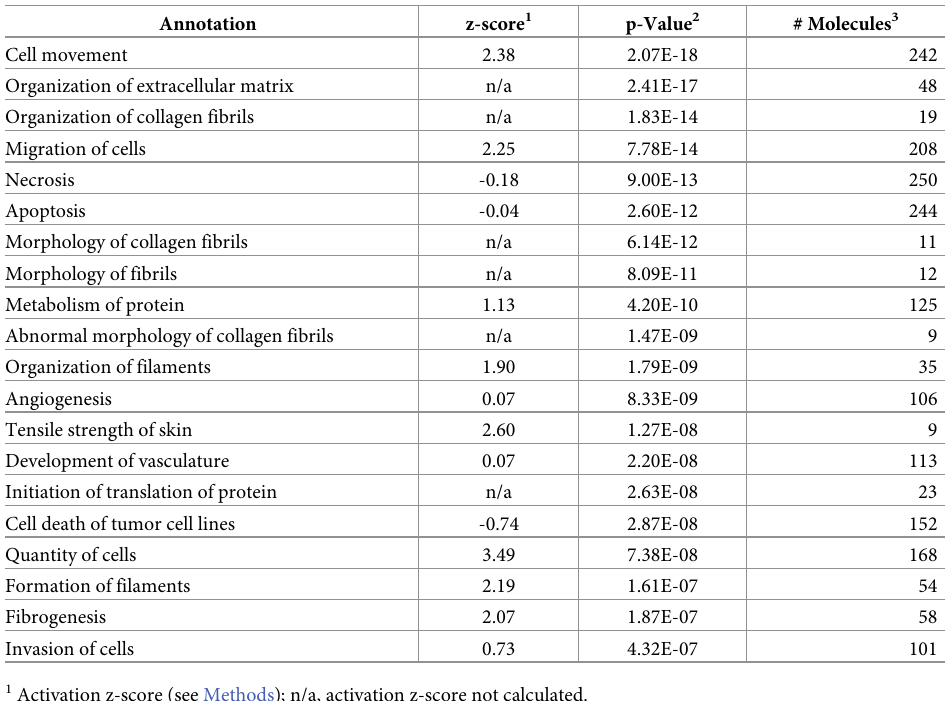
Table 5. Top 20 molecular functions and system development process annotations associated with day 28 post- laser resurfacing treatment (by Fisher’s p